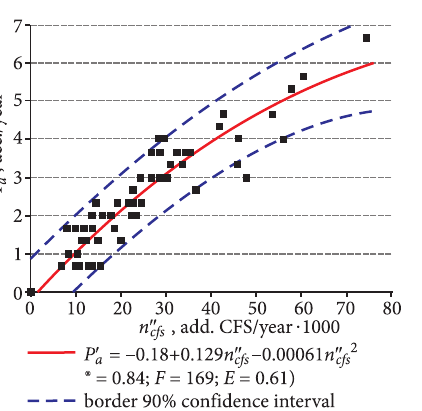
Fig. 1. The accident rate dependence on conflict situations (conflict No. 1, the existing method)